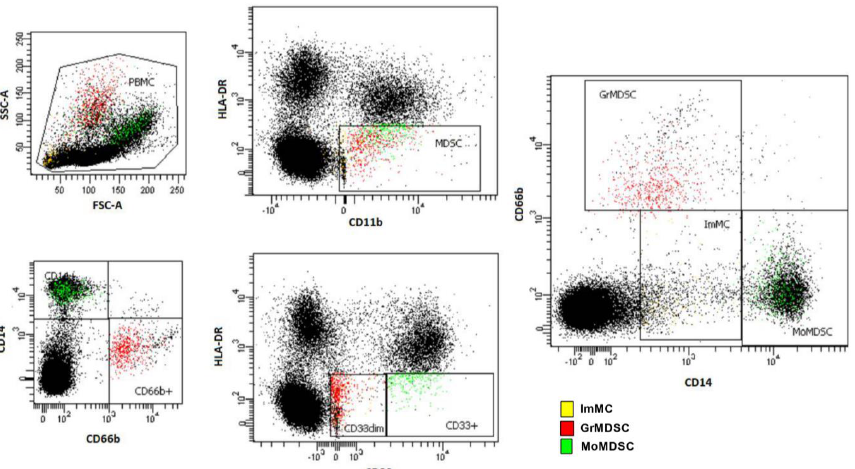
Figure 1. Representative flow cytometry gating for MDSCs as CD11b + /HLA-DR − /low/CD33 + , immature MC (ImMC): CD14 − /low/CD33low/CD11b + /HLA-DR − /low, monocytic MDSC (MoMDSC): CD14 + /CD33high/CD11b + /HLA-DR − /low and granulocytic MDSC (GrMDSC): CD66b + /CD33dim/CD11b + /HLA-DR −